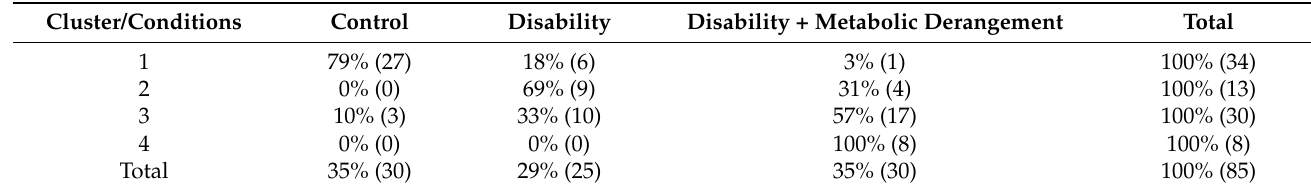
Table 3. The table describes the composition of the clusters obtained from the HCPC in terms of prevalence of the classes of the groups of children studied. Whereas cluster one mainly identifies the group of control children (in fact, 79% are control children), clusters two, three and four are mainly composed of children with neuromotor impairment (only cluster three contains 10% control children). Whereas cluster four mainly identifies the condition of impairment with metabolic syndrome, clusters two and three are much more mixed. Indeed, cluster two contains mainly children with disabilities only (69%) but is nevertheless characterized by 33% children with neuromotor impairment and metabolic syndrome, whereas cluster three mainly contains children with disabilities and metabolic syndrome (57%) but is nevertheless characterized by 33% children with disabilities